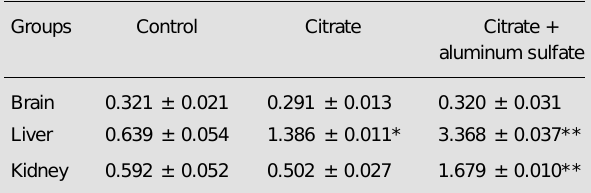
Table 3 - Tissue aluminum concentration determined by graphite furnace atomic absorption spectrometry (GFAAS). Data are reported as µg/g wet weight. *P<0.05 compared to control (Duncan test); **P<0.05 compared to control and to the citrate group (Duncan test). Each result represents the mean for six animals and two determinations by GFAAS.